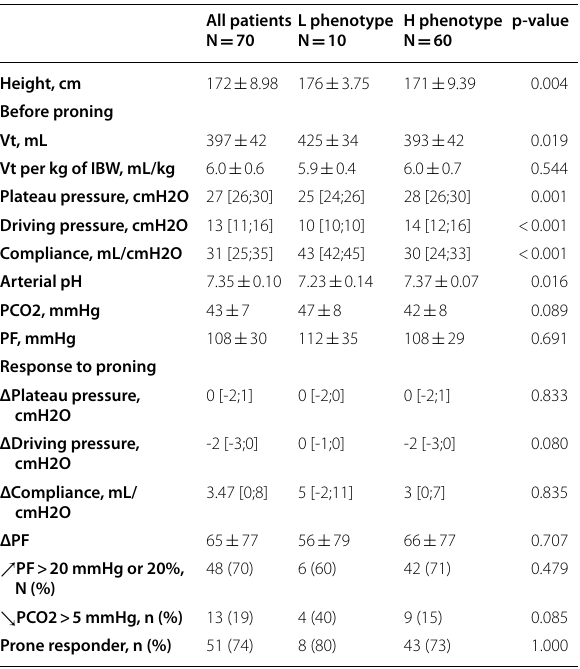
Table 1 Respiratory parameters before and during prone positioning